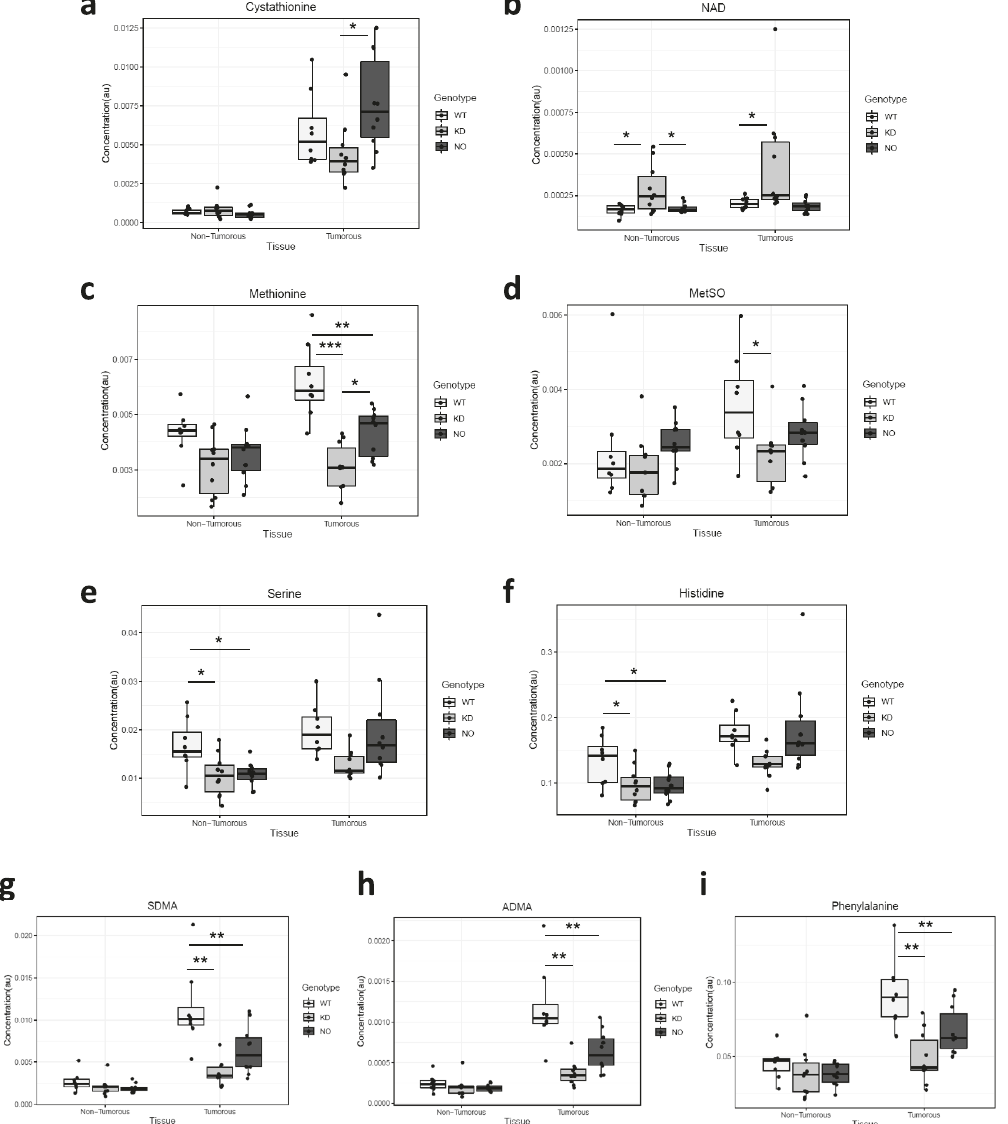
Fig. 7 Knockdown of Keap1 enhances the metabolic alterations in colorectal adenomas. Concentration of selected metabolites in peri-tumorous and tumorous tissues of wild-type (white bars), Keap1-KD (gray bars) and Nrf2-KO (black bars) mice as measured by LC-MS using the C18pfp-based method. ( a ) cystathione, ( b ) NAD, ( c ) methionine, ( d ) methionine sulfoxide (MetSO), ( e ) serine, ( f ) histidine, ( g ) symmetric dimethylarginine (SDMA), ( h ) asymmetric dimethylarginine (ADMA), ( i ) phenylalanine. *0.05 > p > 0.01, **0.01 > p > 0.001, *** p < 0.001, using ANOVA followed by Tukey post-hoc test for statistical signi fi